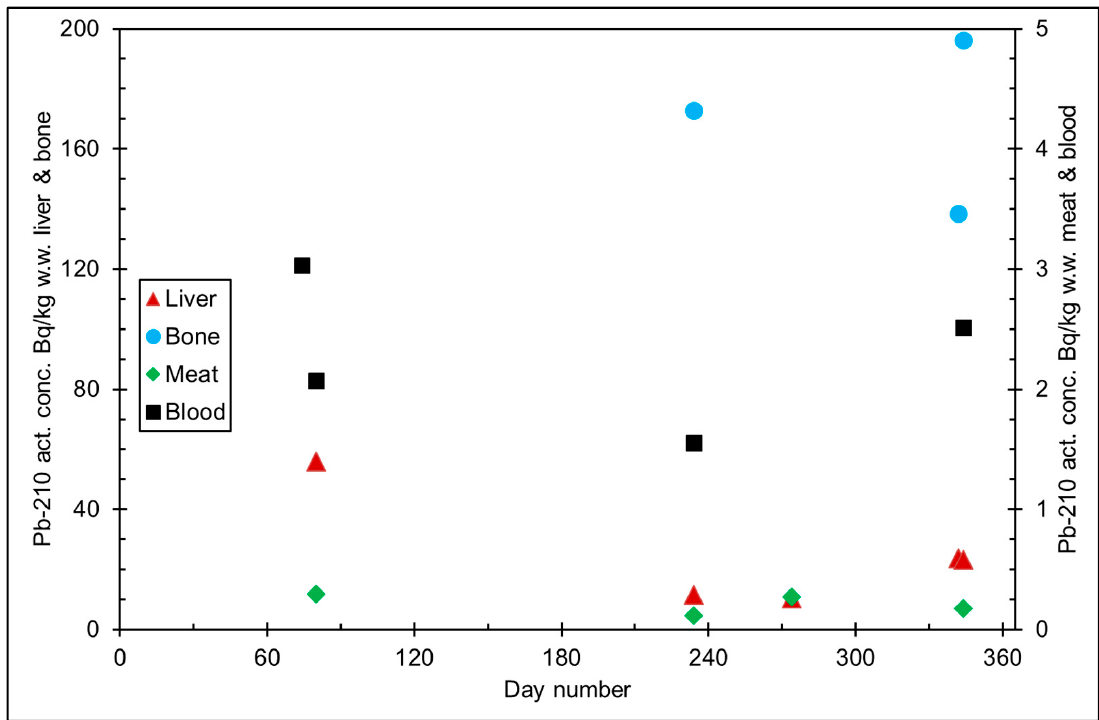
Figure 5. 210 Po activity concentration (Bq/kg w.w. = wet weight) in reindeer tissues, from the data in [15]. Day number refers to Julian day number.